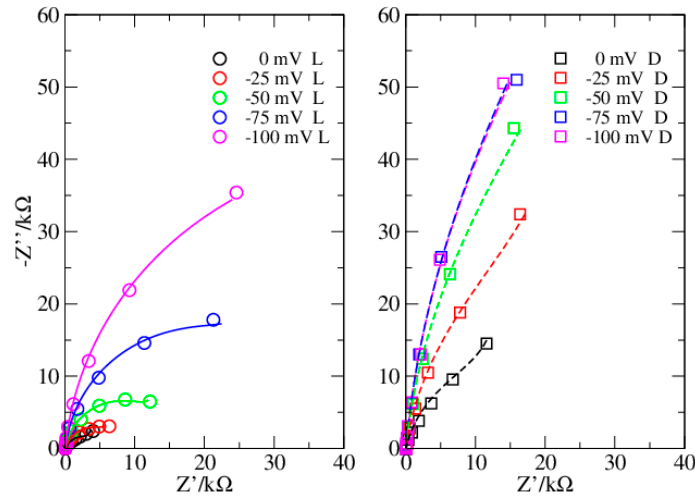
Figure 3. Dataset 2. Data in light (circles) and dark (squares). Lines reproduce data from simulations.